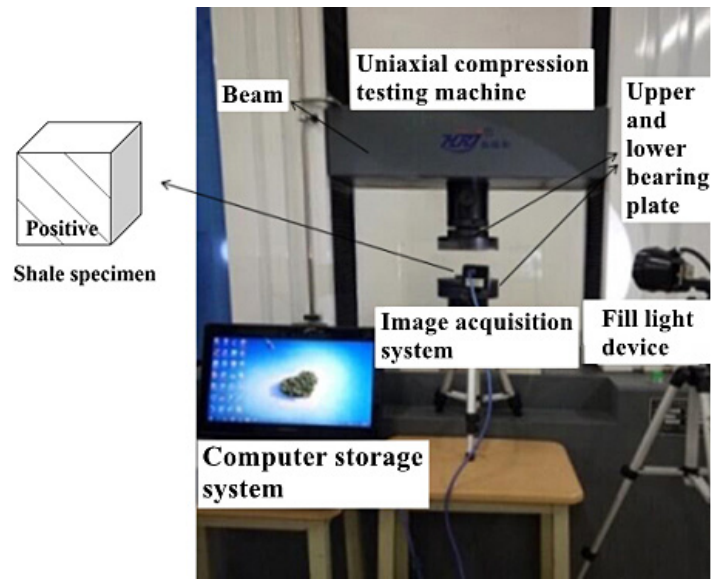
Figure 1. Mesoscopic fracture monitoring device.